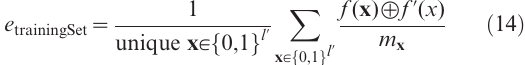
noise=0 noise=0.1 noise=0.3 noise=0.4 selected K ~ 7 selected K ~